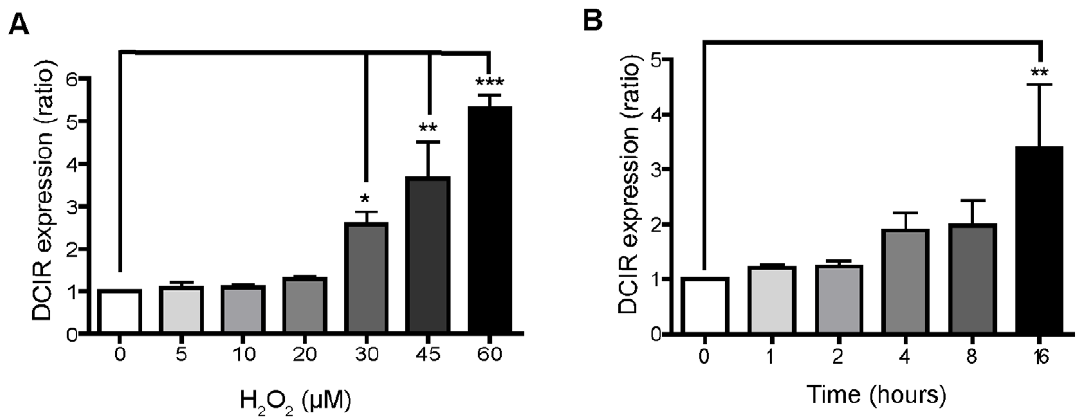
Figure 7. H 2 O 2 mediates both apoptosis and DCIR expression. Mitogen-stimulated CD4 + T cells (1 6 10 6 ) were exposed to increasing concentrations of H 2 O 2 for 16 h (A) or treated with a constant dose of H 2 O 2 (i.e. 30 m M) for the indicated time lengths (B). Next, DCIR expression was assessed by flow cytometry. Data shown represent the ratio of DCIR expression over basal expression. The ratio is calculated from the means 6 SD of triplicate samples from three independent experiments. Asterisks denote statistically significant data (*, P , 0.05; **, P , 0.01; ***, P , 0.001).